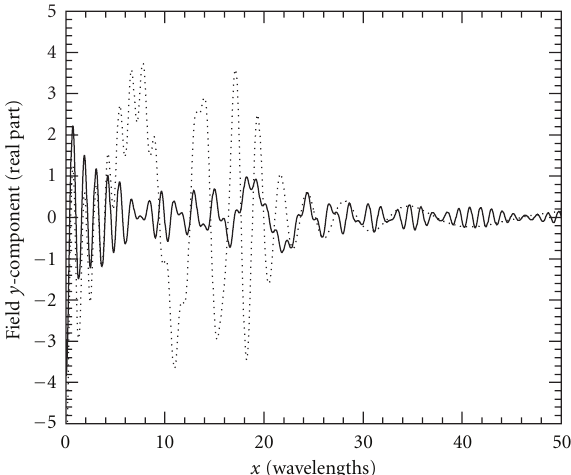
Figure 3: Real part of the NF y -component on the line y = 0, z = 12 λ . Solid line: field. Dashed line: reduced field.